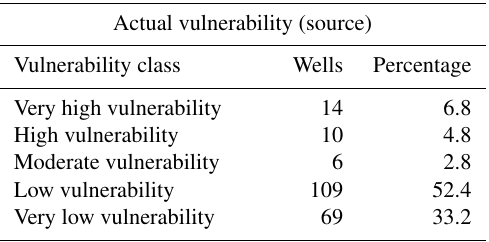
Table 4. Actual vulnerability of extraction wells for water